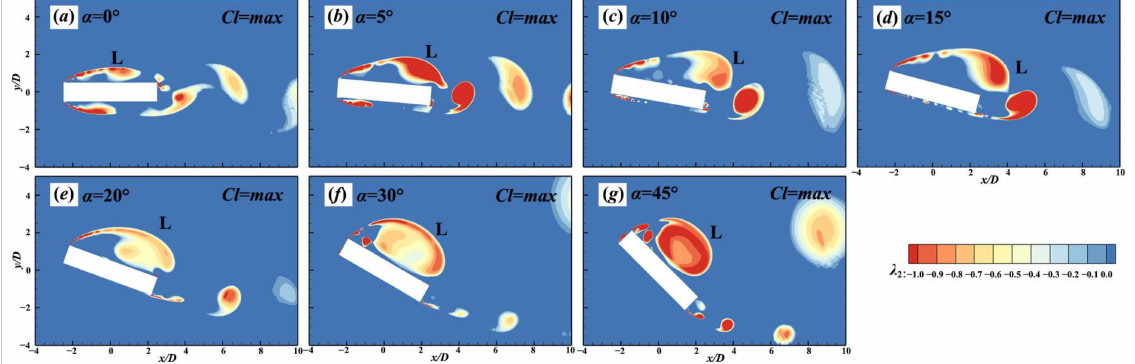
Figure 9. Instantaneous vortex structure with maximum lift coefficient at various AoAs. ( a ) α = 0 ◦ , ( b ) α = 5 ◦ , ( c ) α = 10 ◦ , ( d ) α = 15 ◦ , ( e ) α = 20 ◦ , ( f ) α = 30 ◦ , ( g ) α = 45 ◦